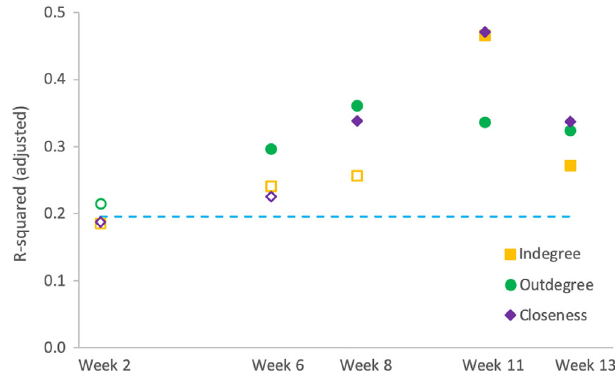
FIG. 5. Scatter plot of R 2 values for the full models adj (final grade ∼ GPA þ centrality) for indegree (yellow square), outdegree (green circle), and closeness (purple diamond), shown chronologically. The horizontal dashed blue line shows R 2 for adj the base model (final grade ∼ GPA) for comparison. We observe a general trend of increasing predictive power as time passes. for models that were not statistically significant Markers for R 2 adj are left